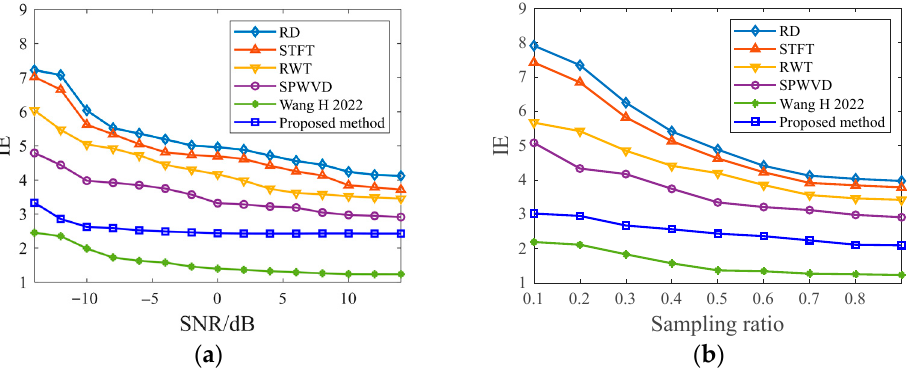
Figure 23. Performance curves of IE versus SNR and sampling ratio of six different methods: ( a ) Performance curves of IE versus SNR; ( b ) Performance curves of IE versus sampling ratio.